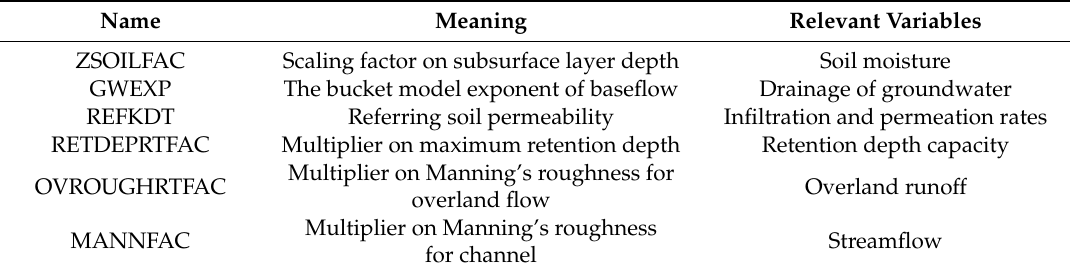
Table 4. The parameterizations of WRF-Hydro